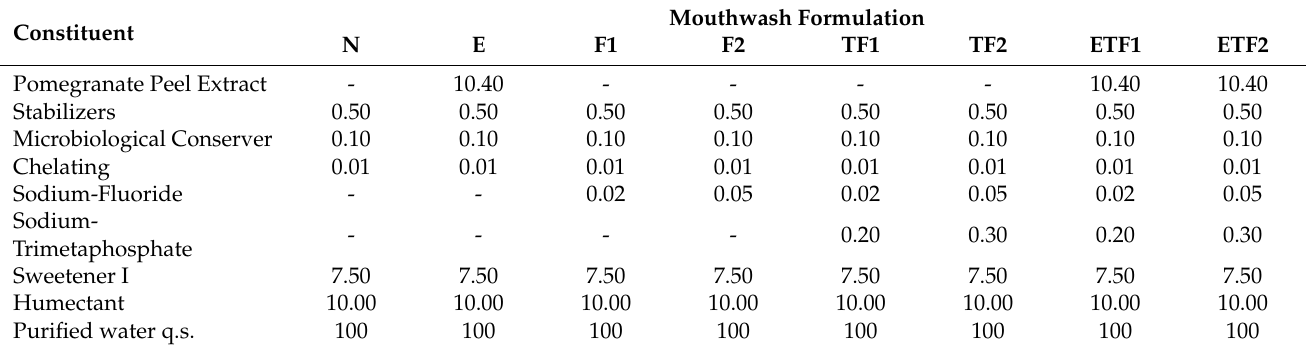
Table 5. Groups of mouthwash formulations designed according to their constituents